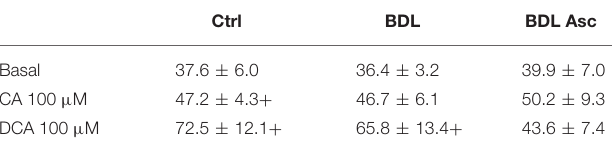
TABLE 2 | Basal calcium levels (nM) in the experimental groups.